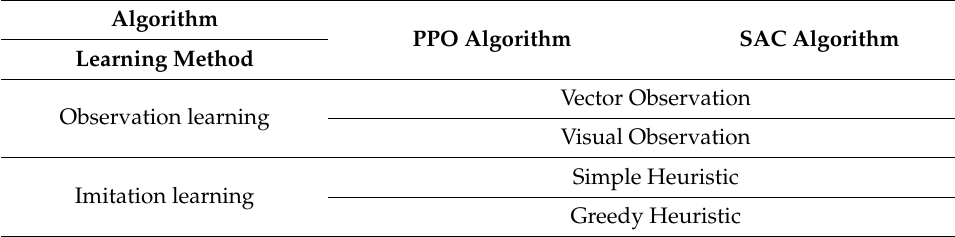
Table 4. Four types of learning method.